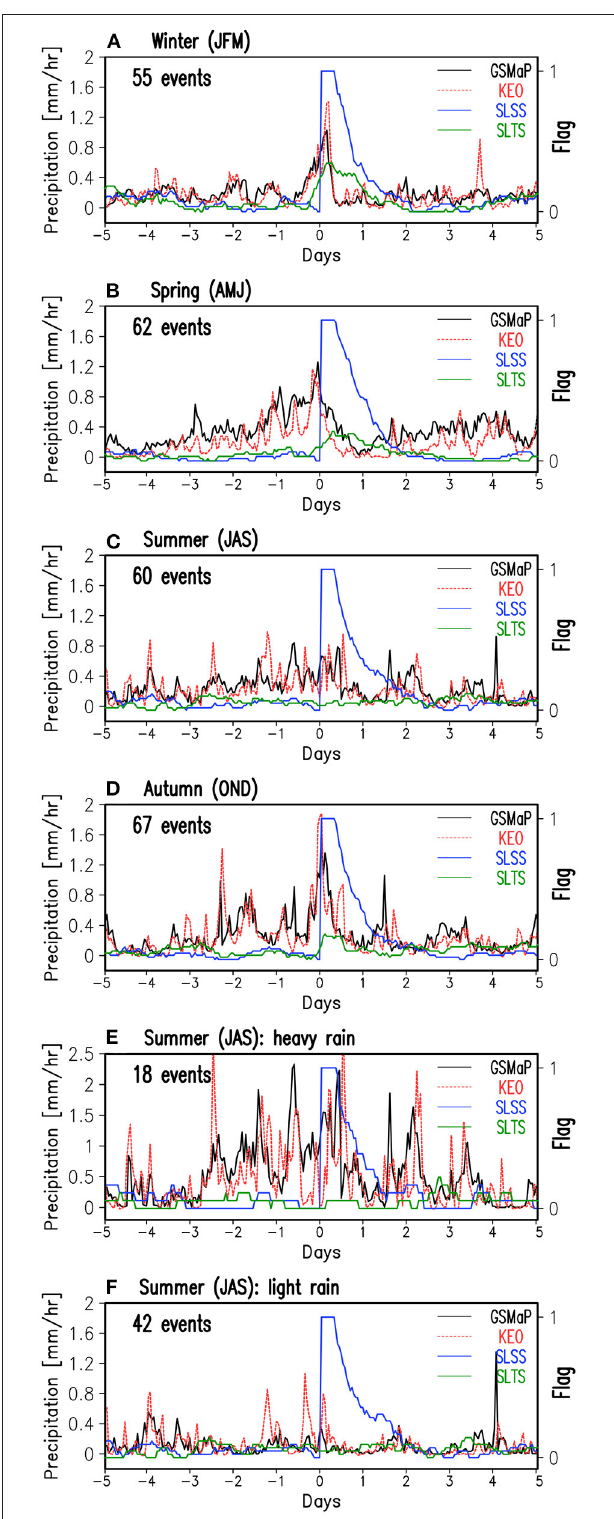
FIGURE 5 | Composite time series of the sporadic event flags defined by equations (3a) and (3b) and the precipitation rate in a 10-day period (from − 5 days to + 5 days relative to the start time of each SLSS event). Time series of